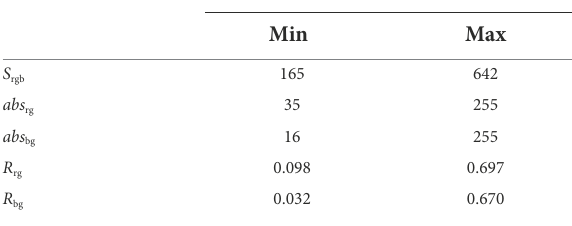
TABLE 1 Color threshold distribution of corn point cloud. Color Threshold range